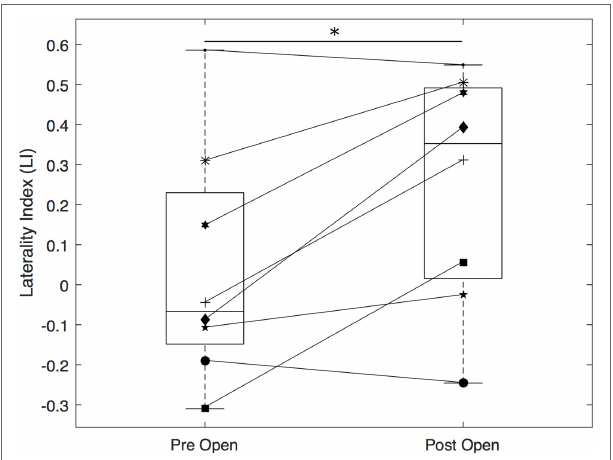
FigUre 3 | Box plots of laterality index (LI) prior to and following the intervention for paretic hand opening. Positive LI indicates predominantly ipsilesional activity. *indicates p < 0.05.